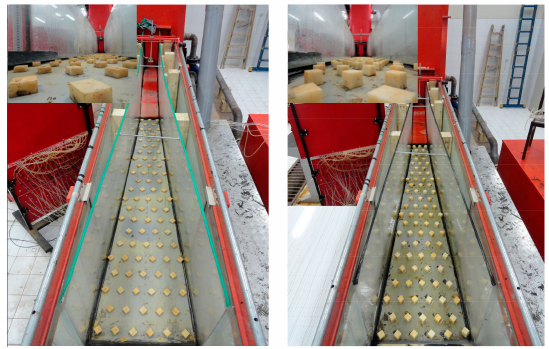
Figure 3. Definition sketch for dissipative elements with lozenge shape with divergence ratio of B = 0.4. ( a ) Height of roughness ( r ) = 1.4 cm. ( b ) Height of roughness ( r ) = 2.8